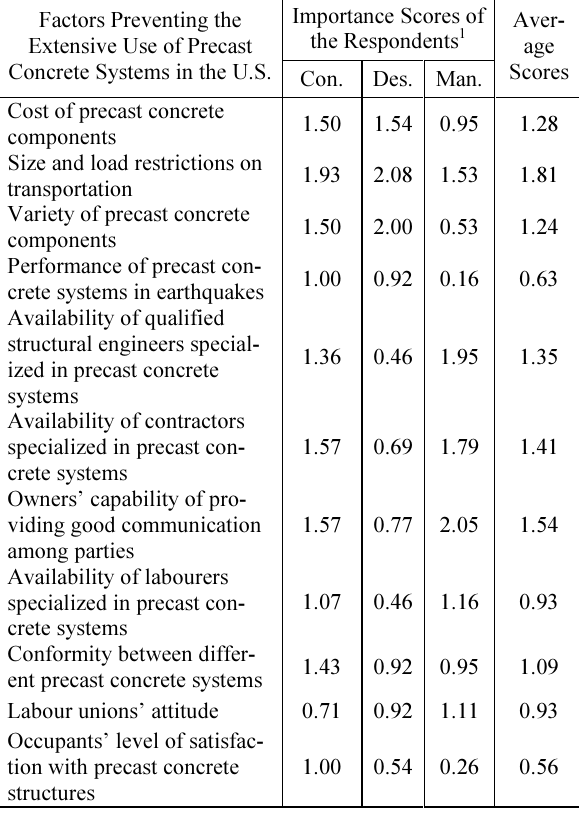
Table 2. Factors Preventing the Extensive Use of Precast Concrete Systems in the U.S.